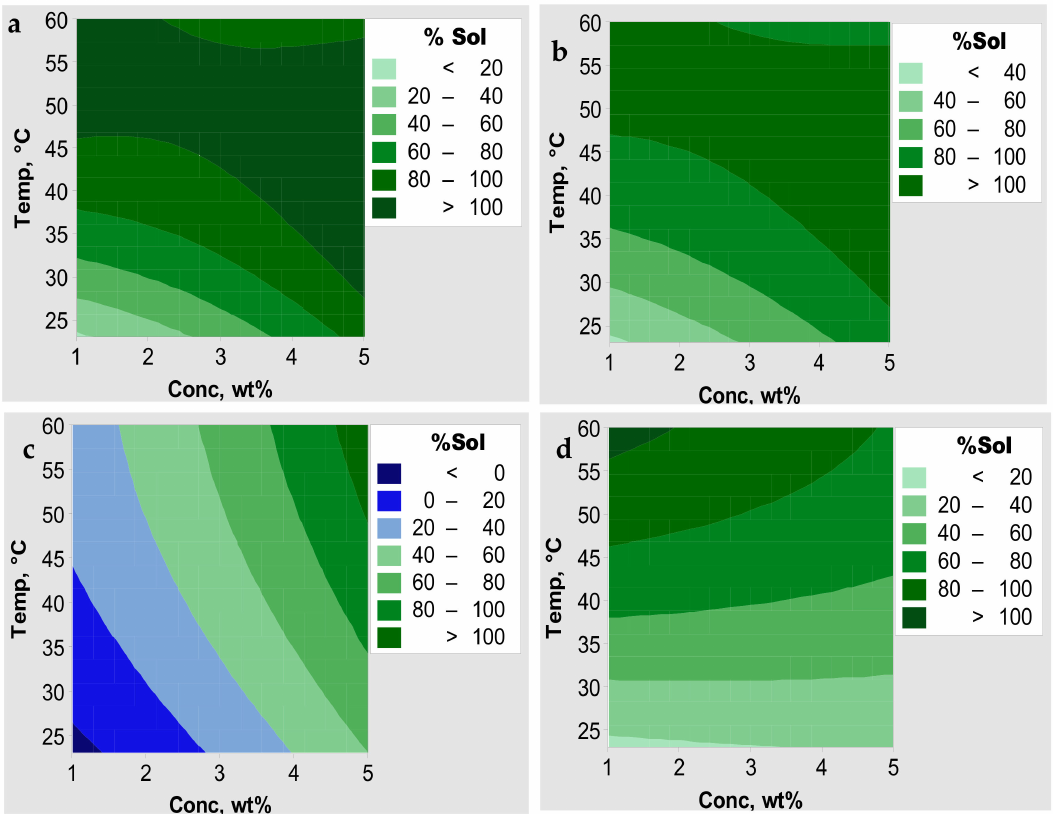
Figure 3. Contour plots for solvation of SF in ( a ) LiCl, ( b ) CaCl 2 , ( c ) LiBr, and ( d ) Ca(NO 3 ) 2 salt–FA solvent